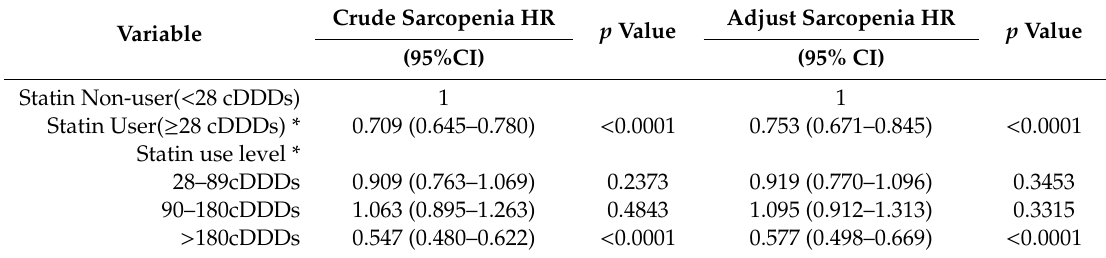
Table 3. Association between statin and first-time sarcopenia among chronic kidney disease (CKD) patients in Taiwan.